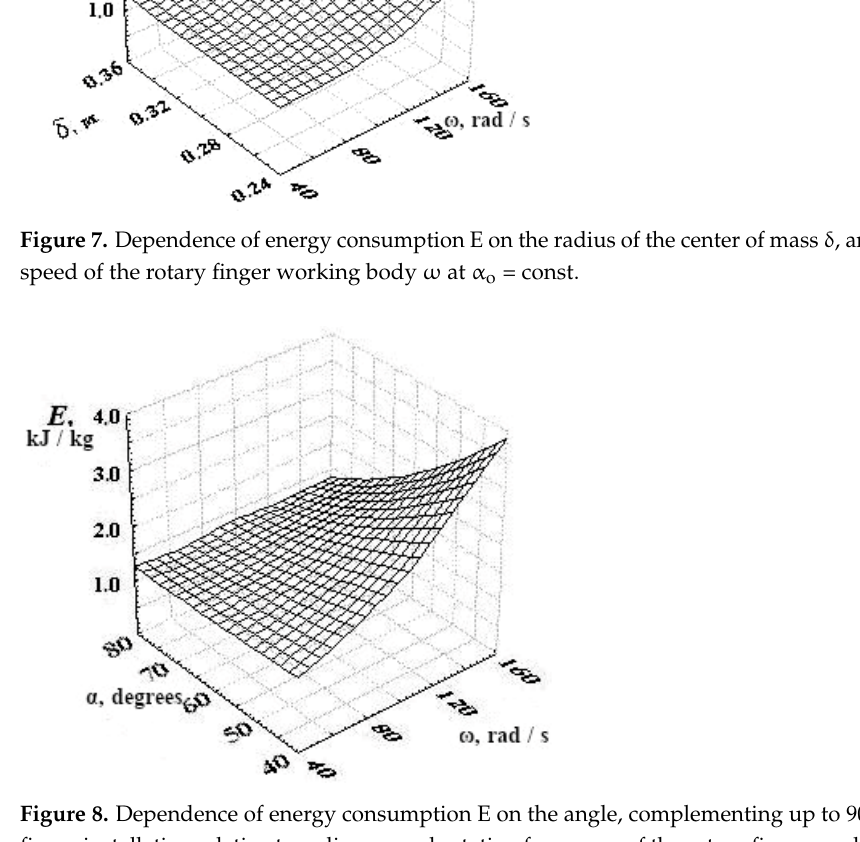
Figure 7. Dependence of energy consumption E on the radius of the center of mass δ, and the rota- tion speed of the rotary finger working body ω at α о = const.